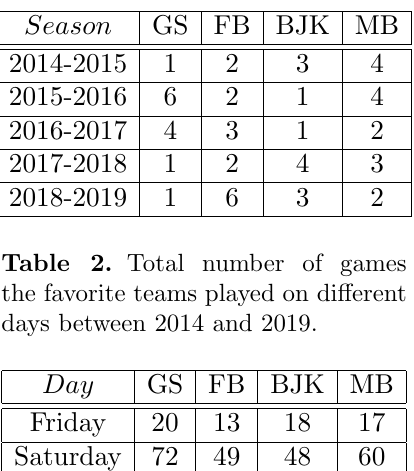
Table 1. Rankings of the favorite teams in different seasons.